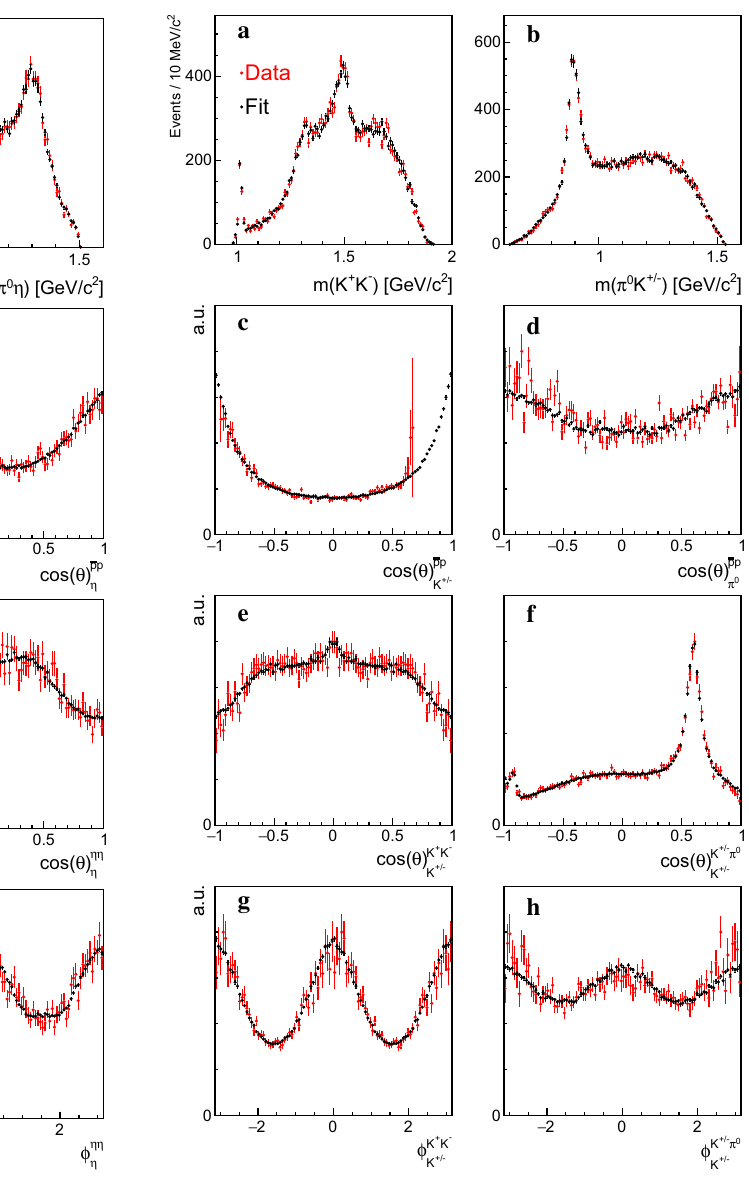
Fig. 9 Not acceptance corrected invariant K + K − and K ± π 0 mass distributions ( a , b ), acceptance corrected decay angular distributions for the production ( c , d ) and for the decay ( e – h ) of the reaction ¯ pp → K + K − π 0 . The data are marked with red and the fit result is illustrated by black dots with error bars